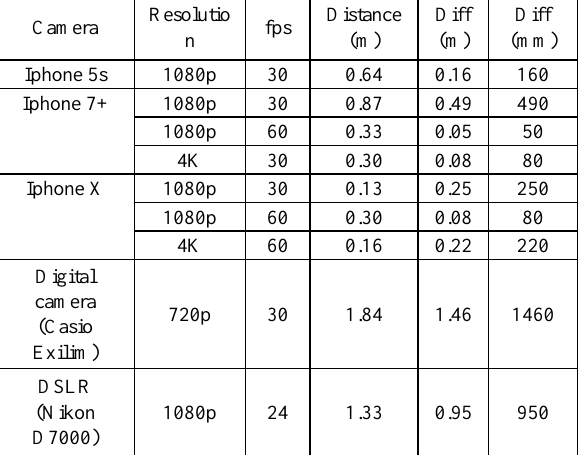
Table 2. Difference distance in x-axis